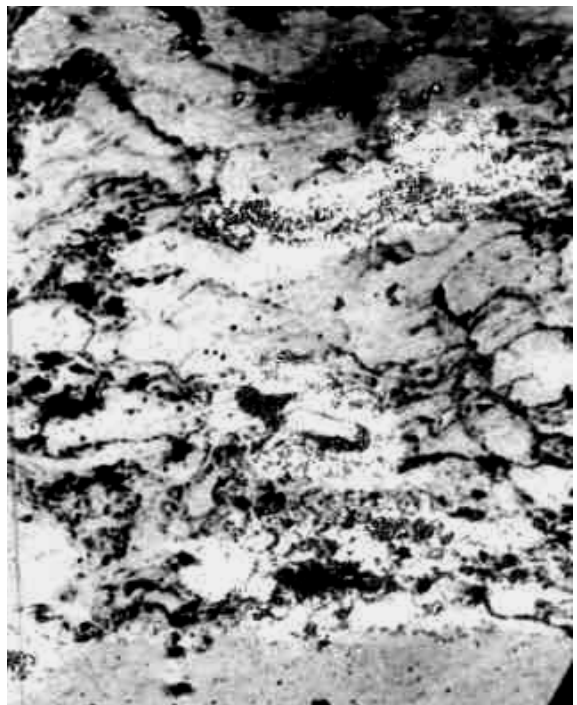
Fig 2. Microstructure of composite detonation coating, x400